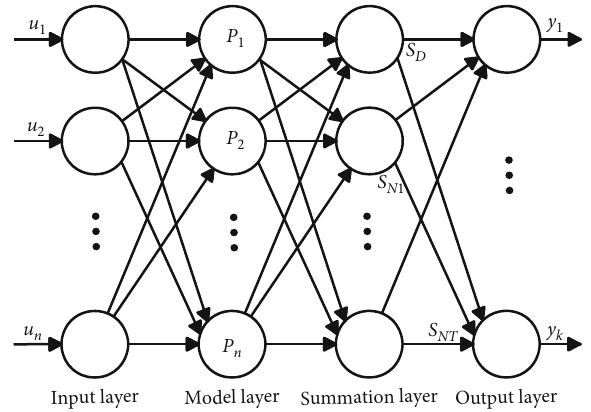
Figure 1: Structure of the GRNN